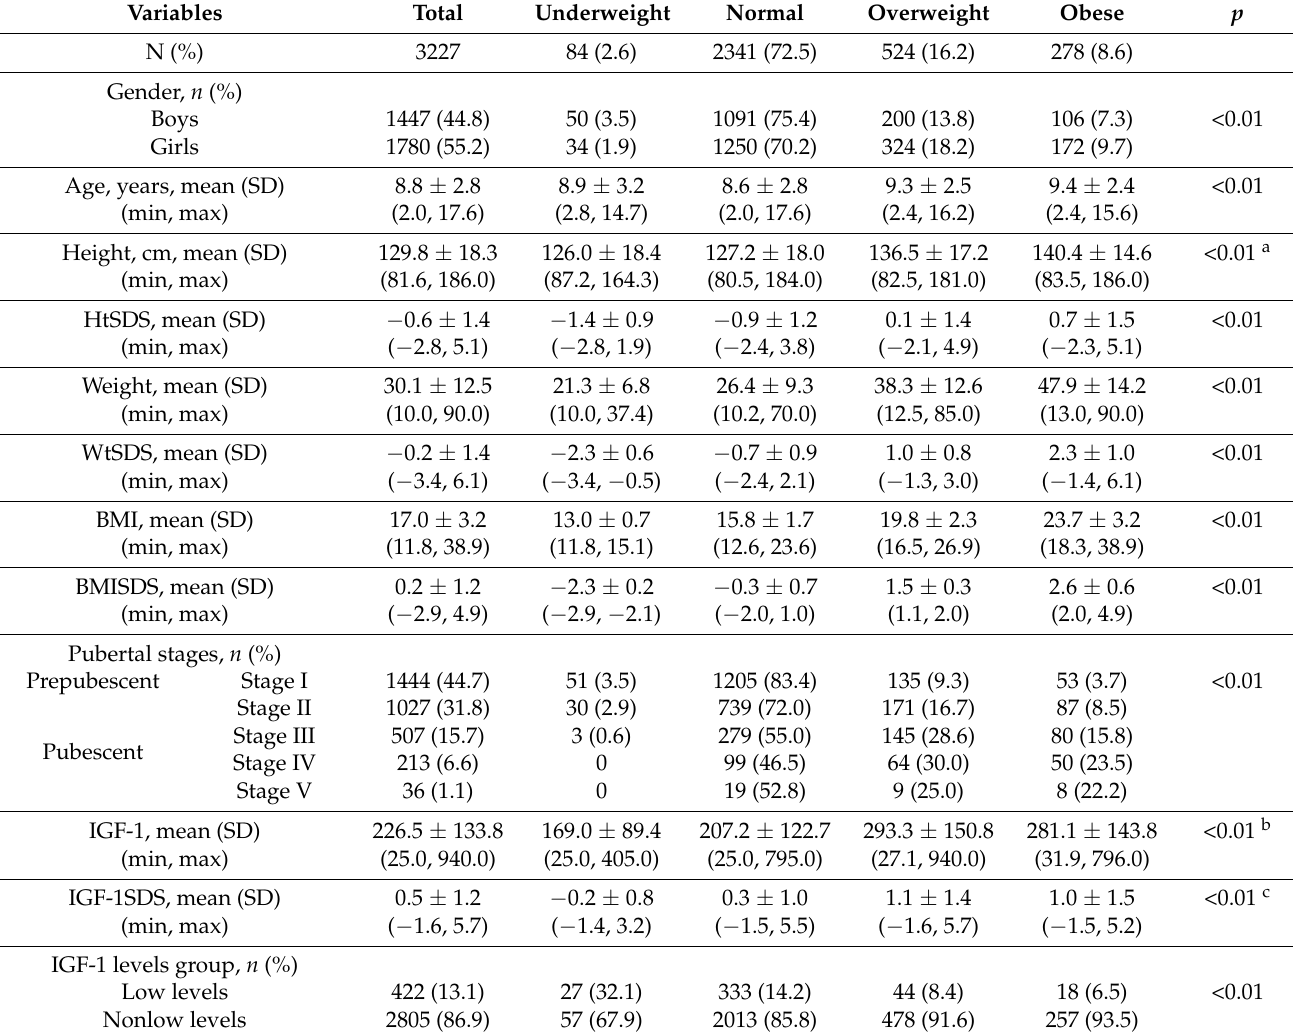
Table 1. Characteristics of participants by nutritional